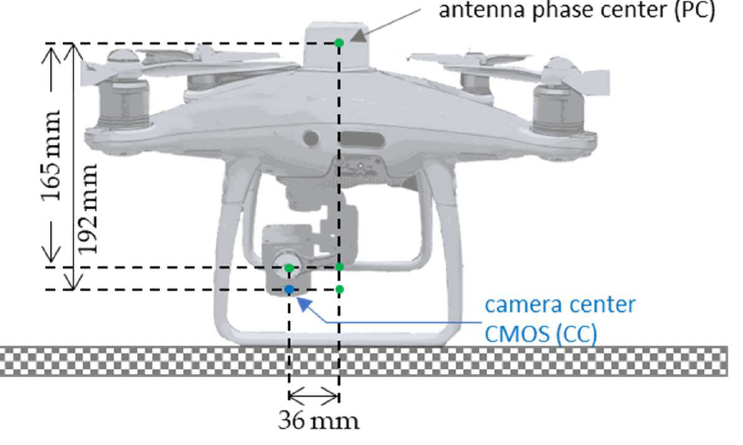
The D-RTK2 base station was stationed above the first GCP and programmed with